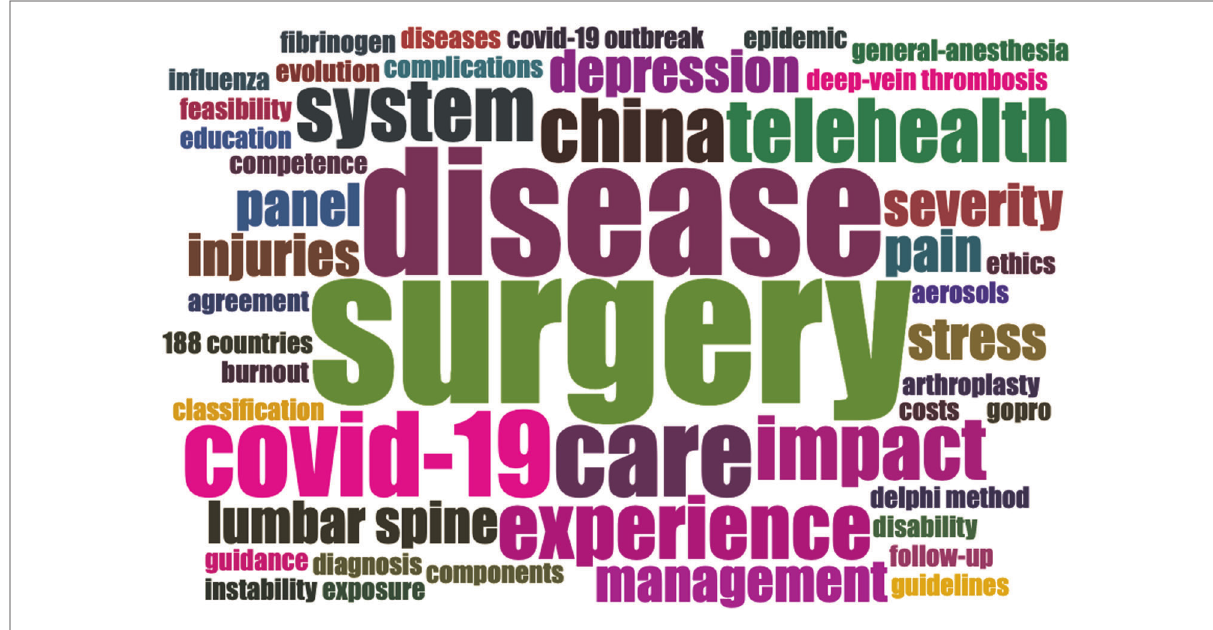
FIGURE 9 Word cloud. The 50 most frequently occurring keywords are displayed. The keywords are located in the center, and the larger the volume, the more frequently it occurs (generated by Bibliometrix).